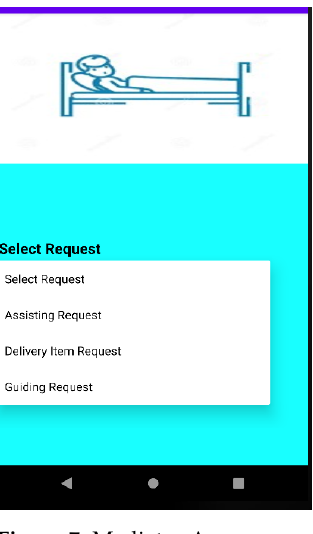
Figure 7. Mediator App. Table 5. Socio-ethical policies and core functions mapping—children’s